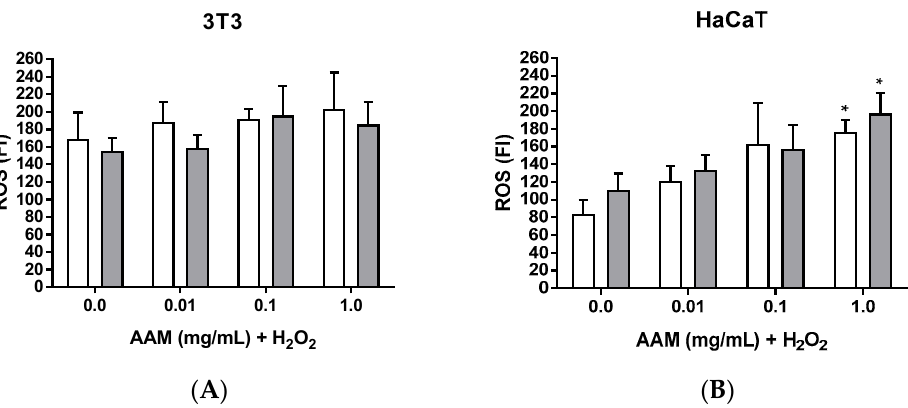
Figure 6. Intracellular ROS induced by 1 and 2 mM H 2 O 2 for 2 h treatment after 24 h incubation with AAM in 3T3 ( A ) and HaCaT ( B ) cells. H 2 O 2 treated cells were used as positive control. White columns correspond to 1 mM H 2 O 2 and gray columns correspond to 2 mM H 2 O 2 . Results are expressed as mean ± standard error of n = 3. A two-way analysis of variance (ANOVA) and a Bonferroni post hoc assay have been performed. Statistical differences were considered as follows: * p ≤ 0.05 in comparison with the corresponding positive control.